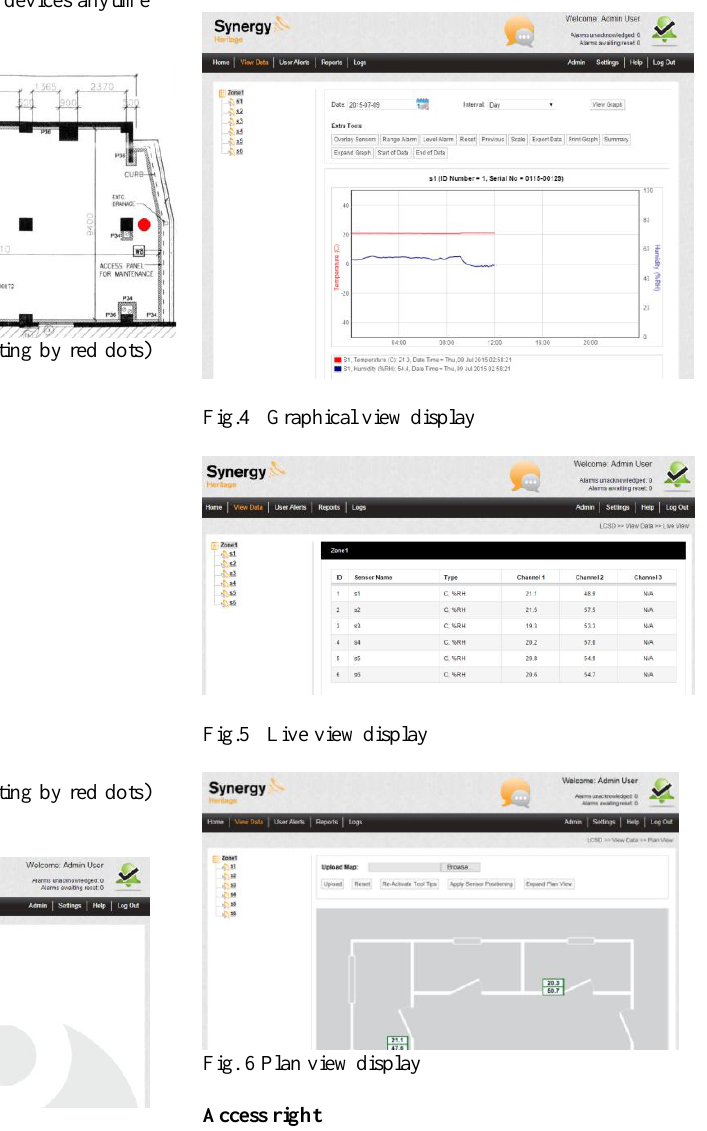
Fig. 3 Homepage of the Synergy Management Tool The management tool enhances the security of the